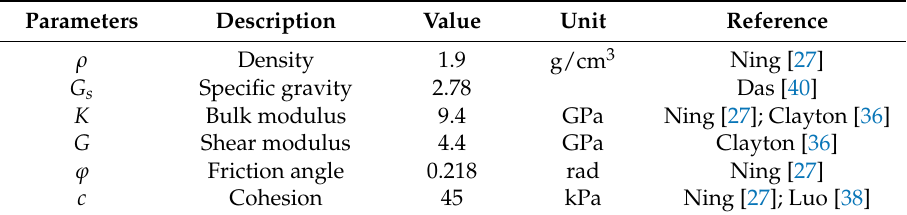
Table 1. Parameters of the material model of hydrate ‐ bearing sediment (HBS).